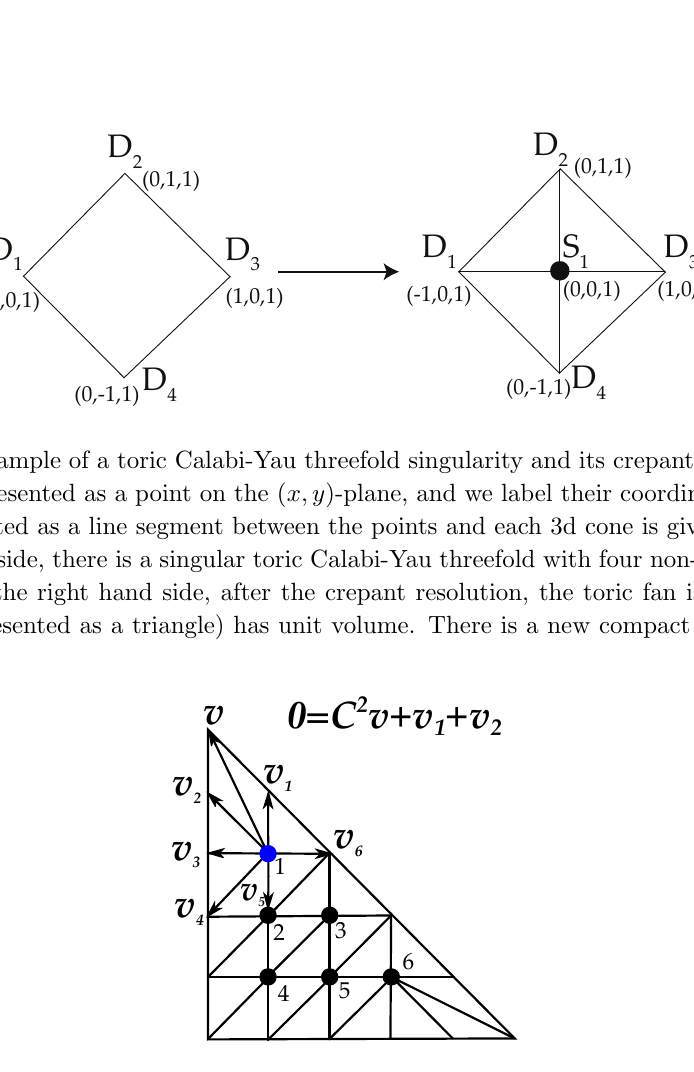
Figure 2 . The resolved toric Calabi-Yau threefold singularity corresponds to the T 5 theory. The toric fan of the compact toric divisor S 1 is constructed including all of its neighboring rays v , v i ( i = 1 ; : : : ;